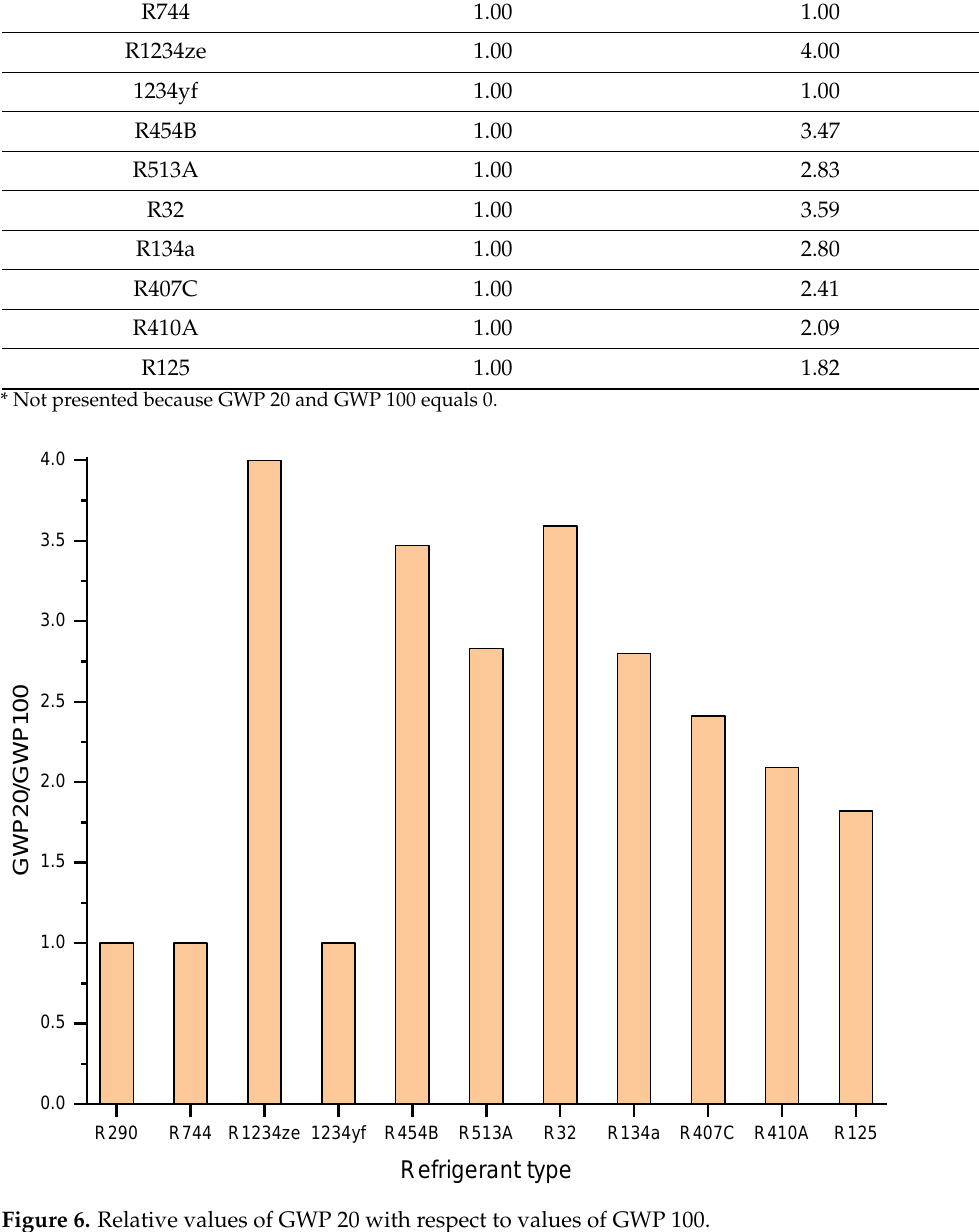
Table 6. Ranges used for presenting the values of CO 2 equivalent released to the atmosphere for GWP 100 and GWP 20.